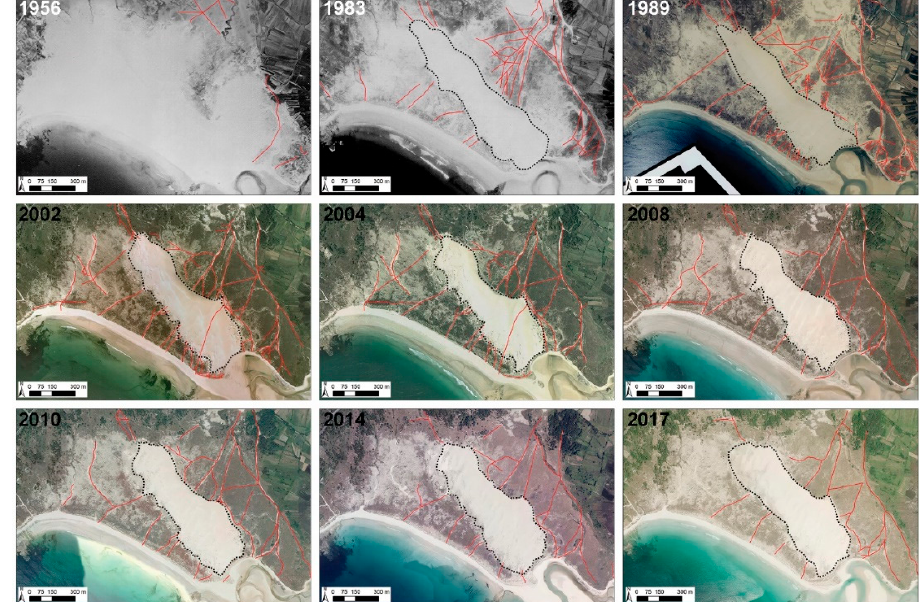
Figure 4. Evolution of pathways in the large shifting dune sector since 1956 to 2017. The pathways (red lines) are on the aerial images and orthophotographs of each data where one can observe the variations in dune extension (black dashed line). In the case of 1956 image, the dune extension is not marked for the difficult to define their boundaries in that image.